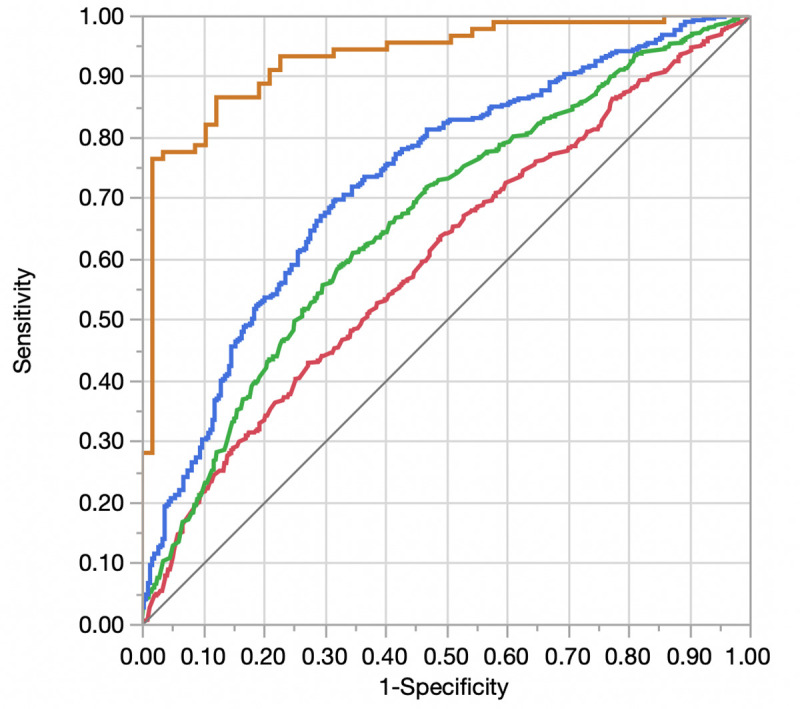
Receiver operator curve displaying differences in discrimination between adjusted models for heart failure readmission.Red = Model 1 (Demographics and Physiologic Variables); Green = Model 2 (Model 1 + Comorbidities); Blue = Model 3 (Model 2 + Echocardiographic Structural Variables); Orange = Model 4 (Model + Echocardiographic Diastolic Variables).